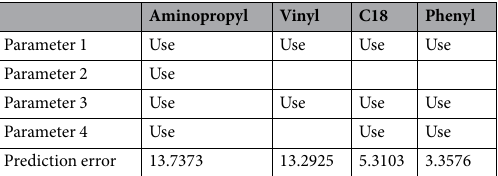
Table 1. Optimal combination of parameters and optimal prediction error depending on the receptor layer material under an ambient